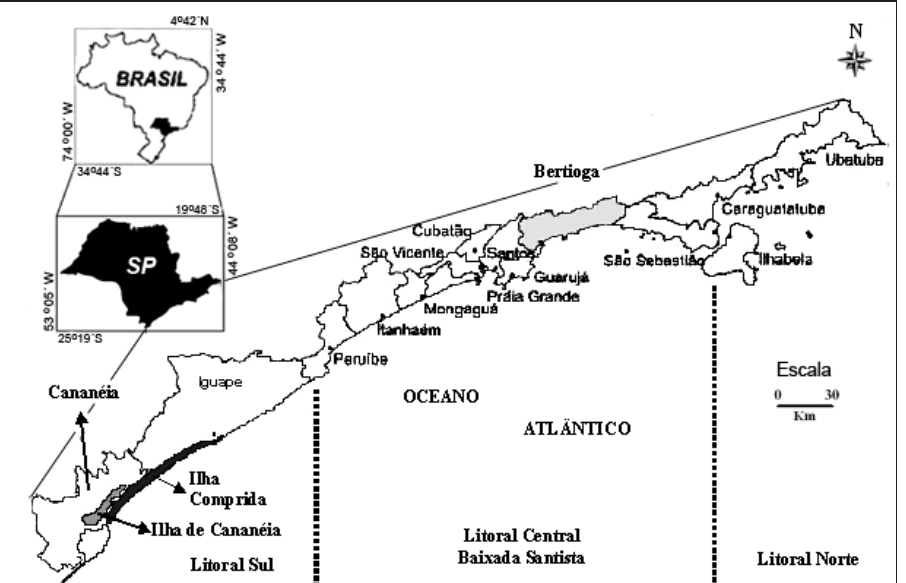
Figura 1. Localização dos municípios de Bertioga, Cananeia e Ilha Comprida no litoral do estado de São